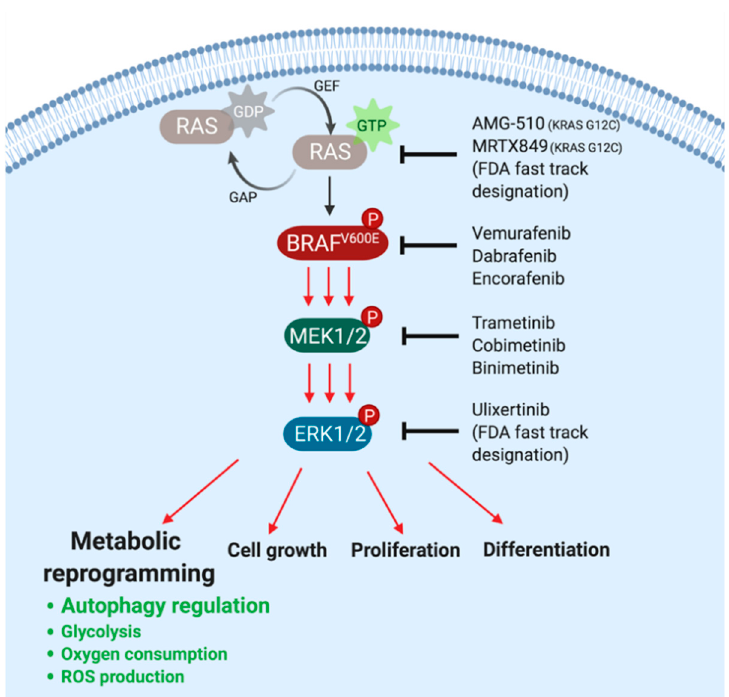
Figure 1. The BRAF → MEK1/2 → ERK1/2 signaling pathway and FDA-approved targeted therapy. RAS-GDP to RAS-GTP exchange triggers a BRAF → MEK1/2 → ERK1/2 phosphorylation cascade, resulting in metabolic reprograming, cell growth, proliferation, and differentiation. FDA-approved or fast-track-designated inhibitors targeting the MAPK components, as indicated.